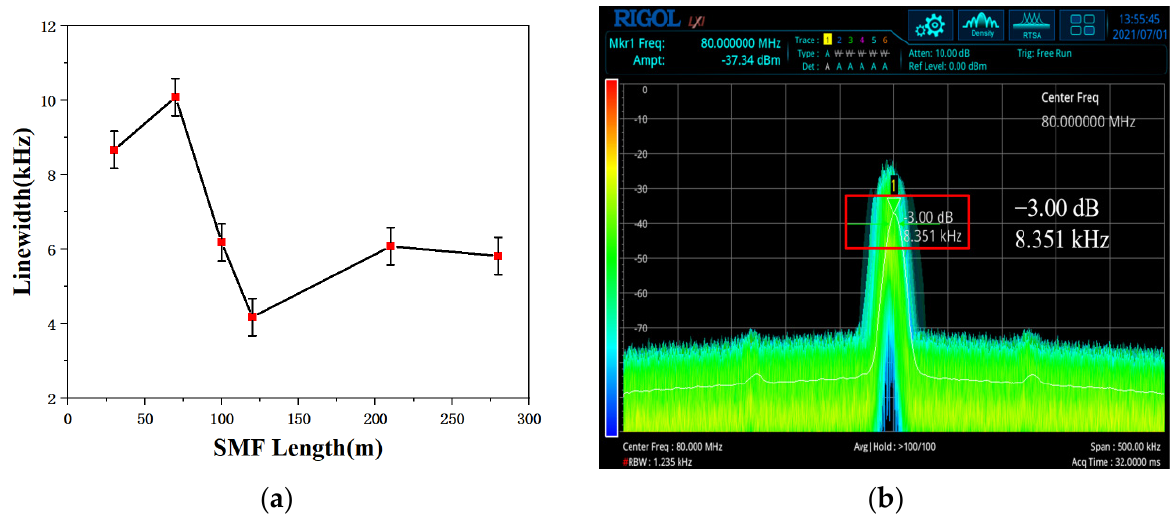
Figure 5. ( a ) Laser linewidth variation for different lengths of SMF. ( b ) Laser line widths using Rayleigh backscattering methodology as SMF lengths of 120 m.